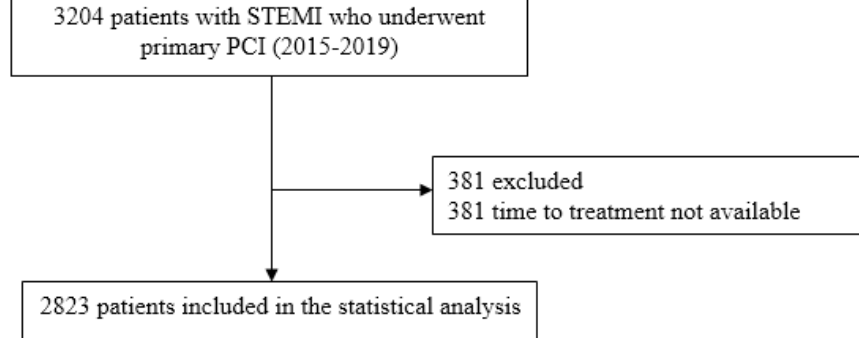
Figure 1. Study population diagram. PCI: percutaneous coronary intervention; STEMI: ST-segment elevation myocardial infarction.